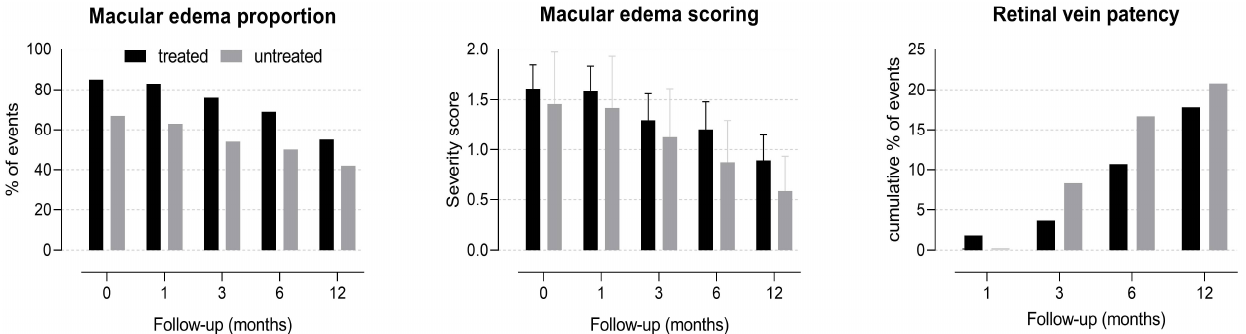
Figure 2. Ophthalmological outcomes of hypertensive patients with retinal vein occlusion during one-year follow-up after receiving (black bars) or not (grey bars) antithrombotic treatment and respective 95% confidence interval (vertical capped lines). p for trend over time <0.050 for all series independently of antithrombotic treatment.